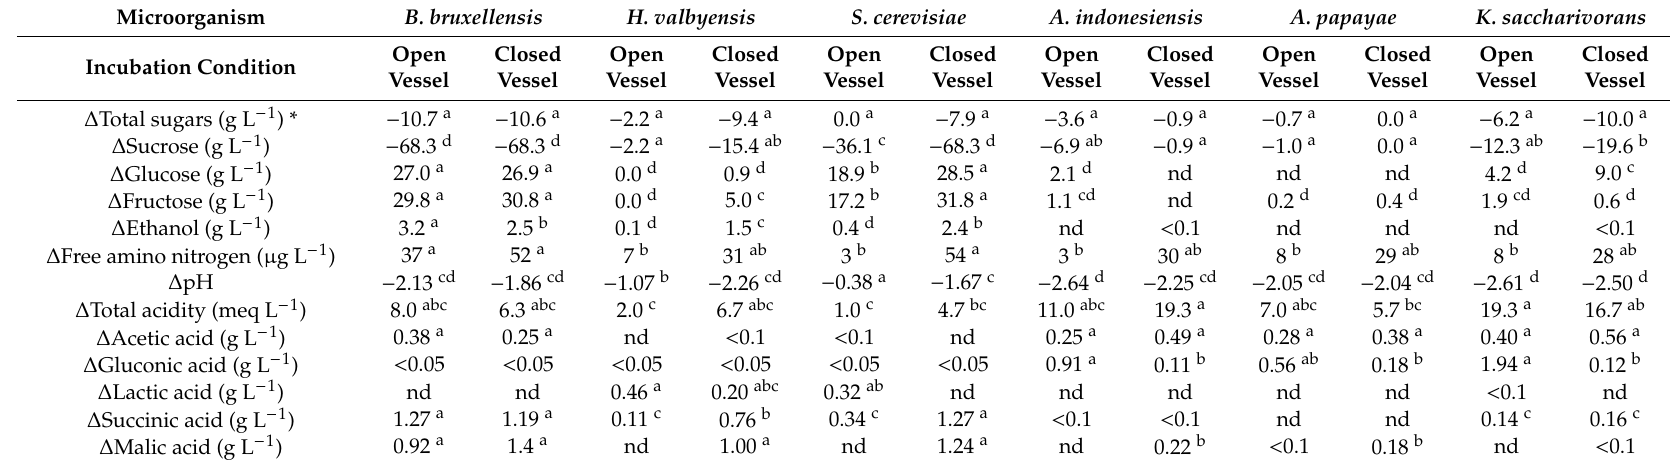
Table 1. Change in the chemical composition of sugared black tea by pure cultures of yeast and bacterial strains isolated from black tea kombucha after 14 days in open and closed conditions of